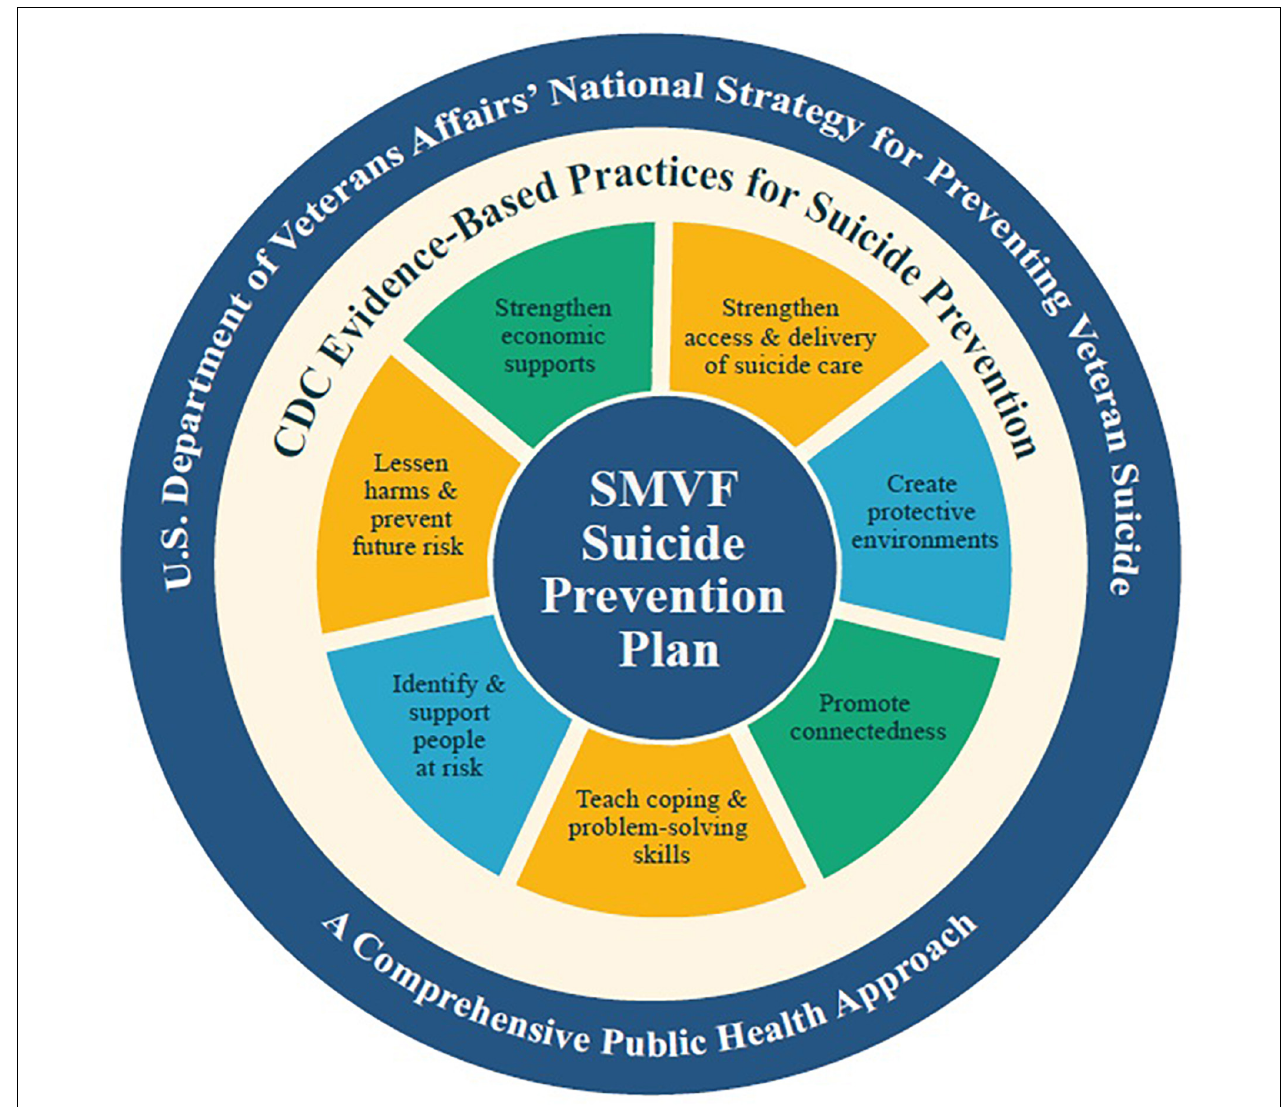
FIGURE 1 | Service Member, Veteran and Family Member (SVMF) Suicide Prevention Model (Substance Abuse and Mental Health Services Administration [SAMHSA],